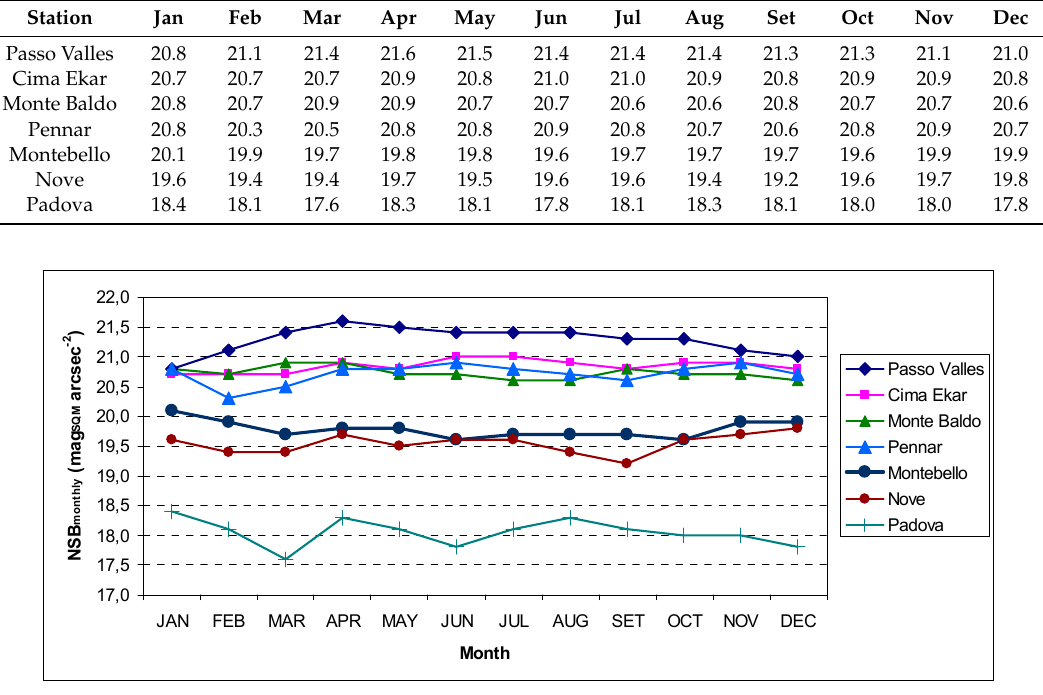
Table 3. Monthly modal NSB value (mag SQM arcsec − 2 ).